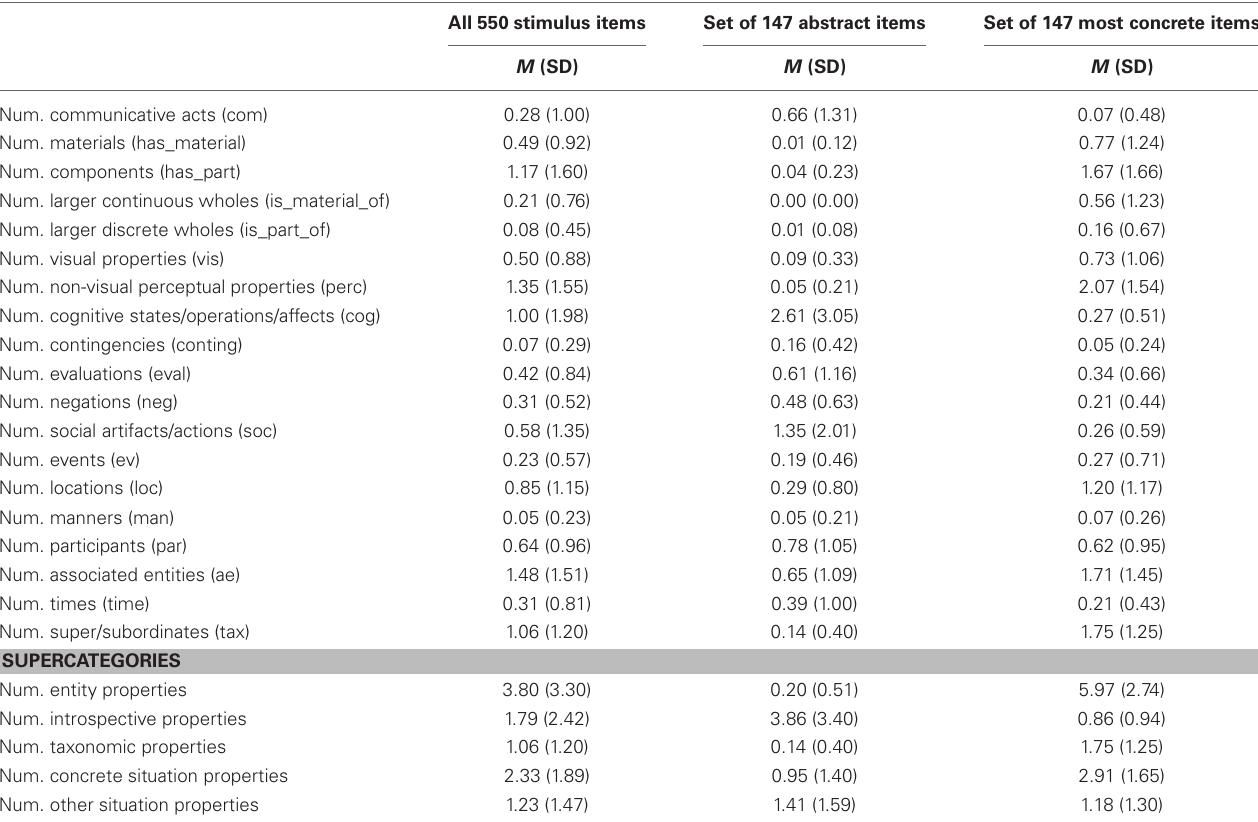
Table 5 | Descriptive statistics for type counts of different feature